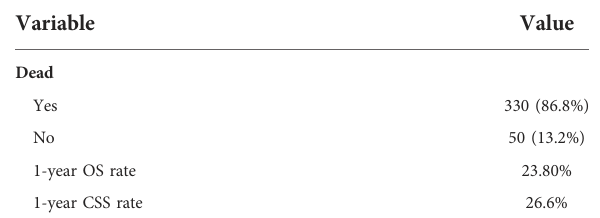
TABLE 1 Baseline characteristics of 380 UTUC with bone